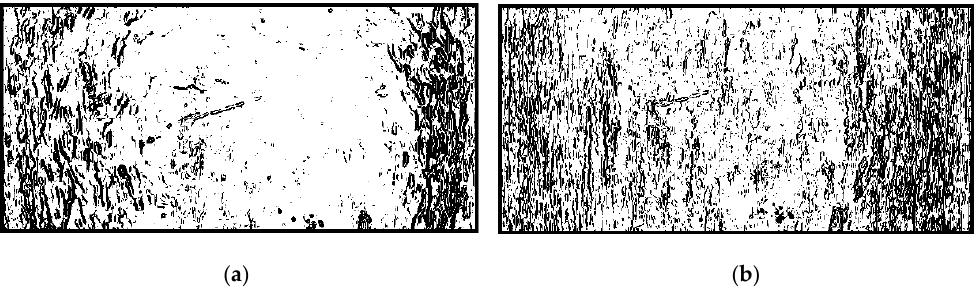
Figure 3. Photos of the liquid film in the tower equipped with cone-shape confusor K 0 : ( a ) Re G = 74,037, Re L = 632; ( b ) Re G = 74,037, Re L = 11,379.